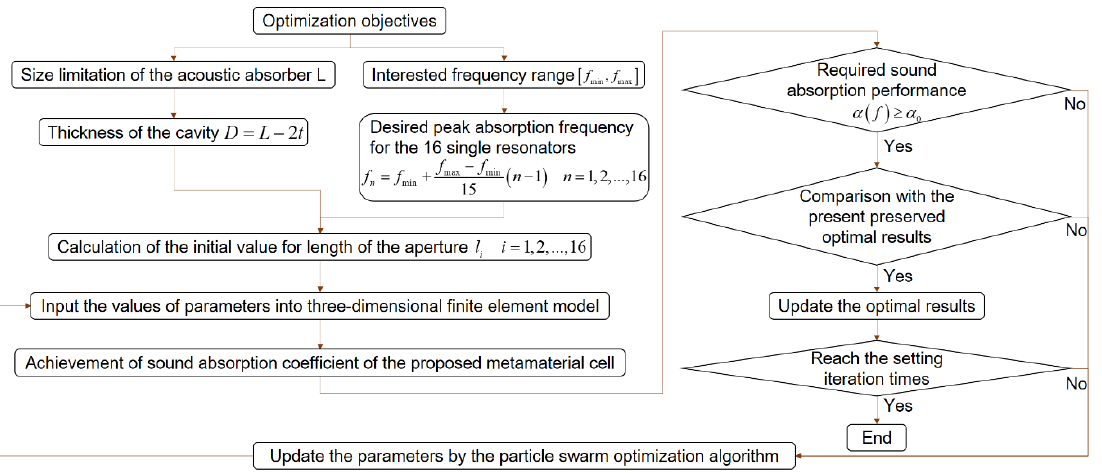
Figure 5. Flow chart of optimization process for the proposed metamaterial cell with given objec-